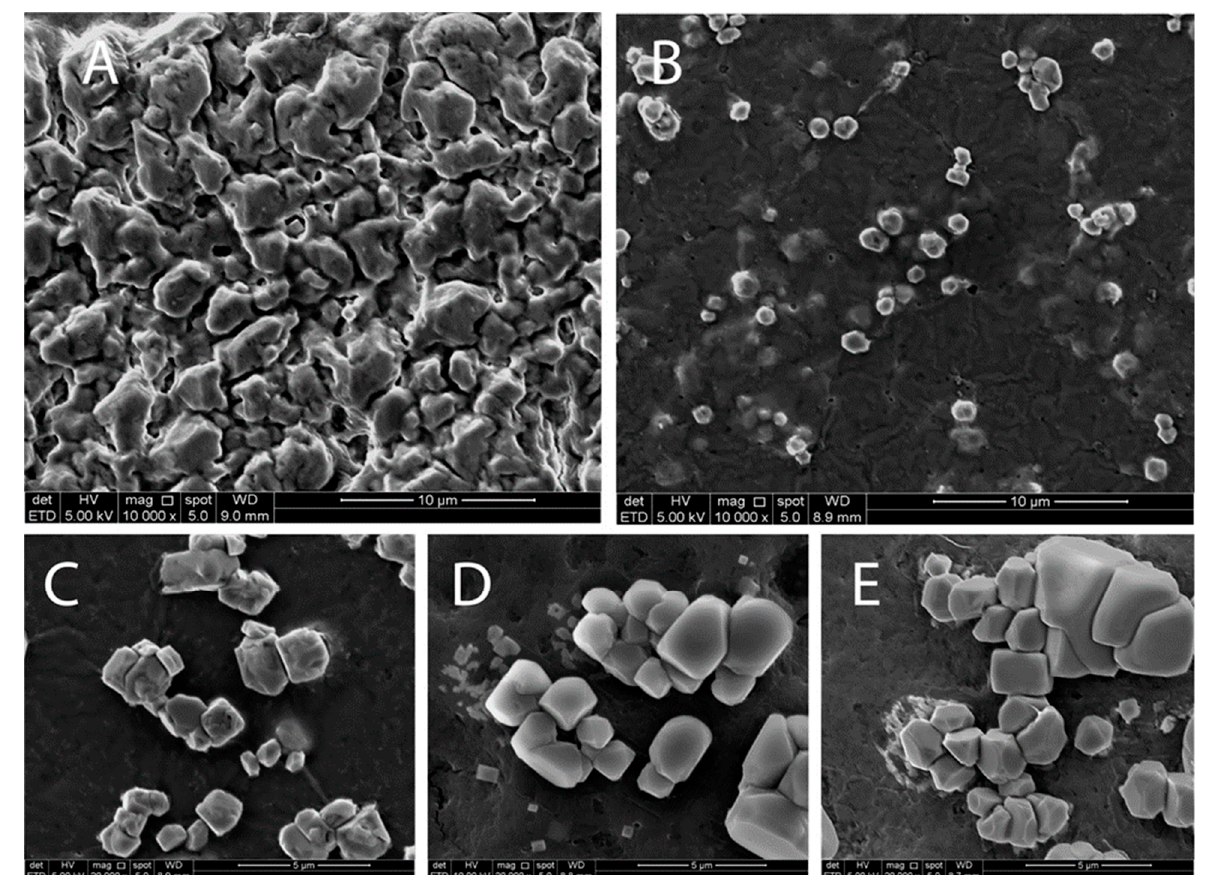
Figure 4. Morphology of the surface of ( A ) lentil proteins (LP), ( B ) casein proteins (CP), and lentil– casein protein complexes (LCPC) with various LP:CP ratios; ( C ) LCPC 1.0:0.1, ( D ) LCPC 1.0:0.5, and